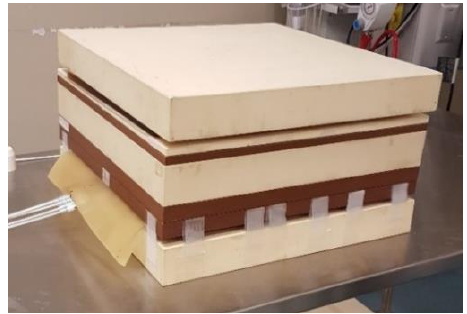
Figure 4. Dose rate dependence phantom. The phantom used to test OSLD dependence on dose rate. An additional 8 cm of solid water was added to the middle of the phantom to provide a total source-to-OSLD distance of 12 cm, as shown in this